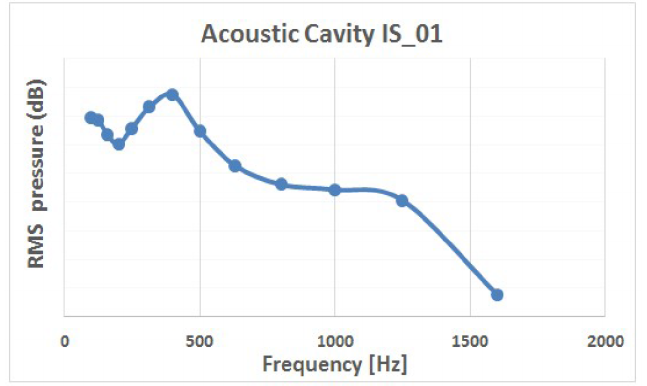
Figure 6. The acoustic cavity response in terms of the root-mean-square (RMS) pressure (dB) for the IS01